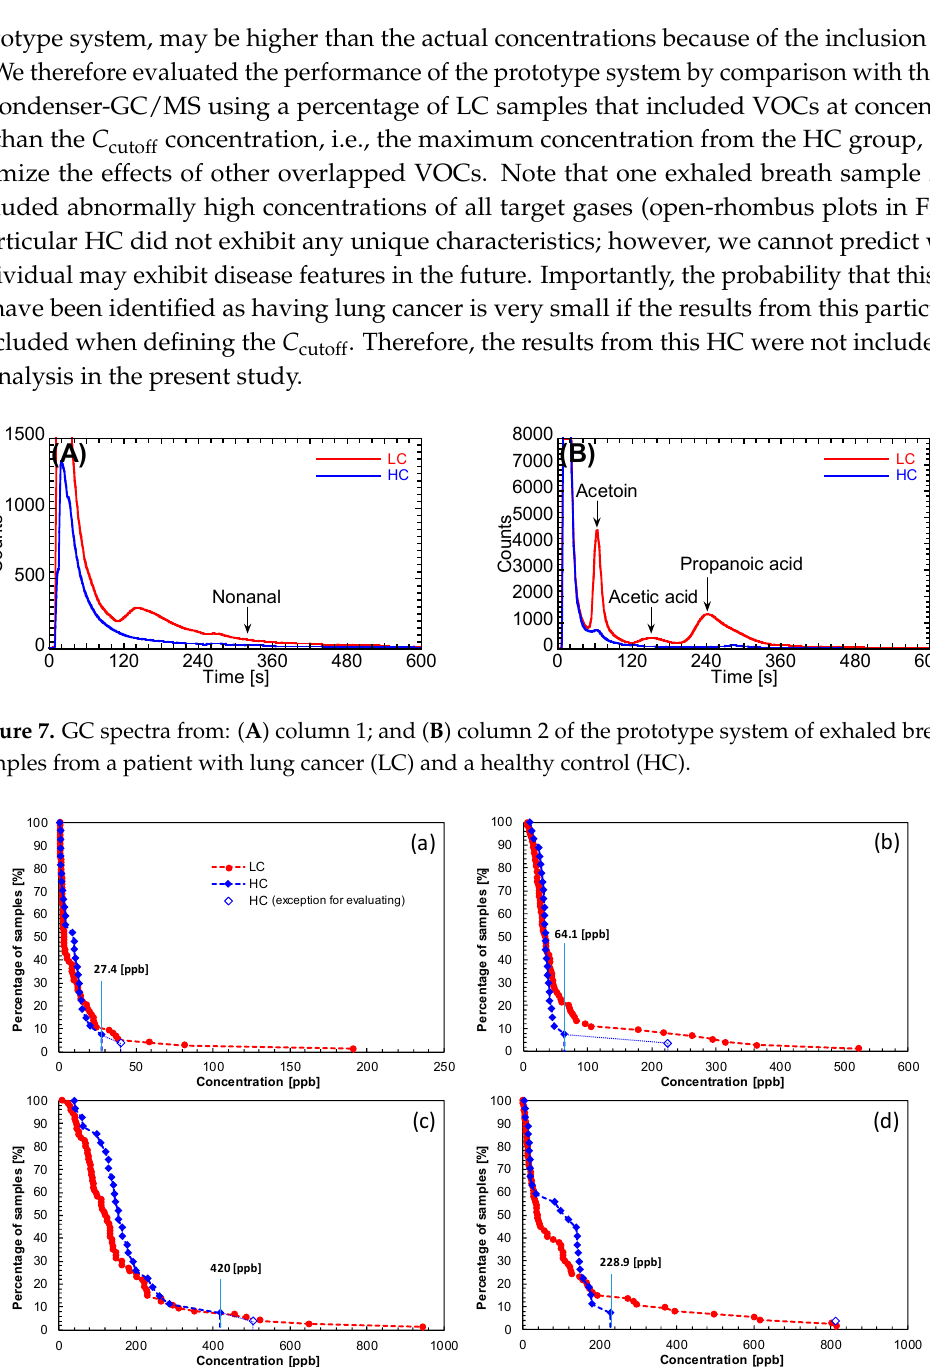
Figure 8. Percentages of samples having higher concentrations of: ( a ) nonanal; ( b ) acetoin; ( c ) acetic acid; and ( d ) propanoic acid on the prototype system. Open-rhombus plots from healthy controls were excluded from the evaluation of the C cutoff because of abnormally high concentrations. LC: patients with lung cancer; HC: healthy controls.